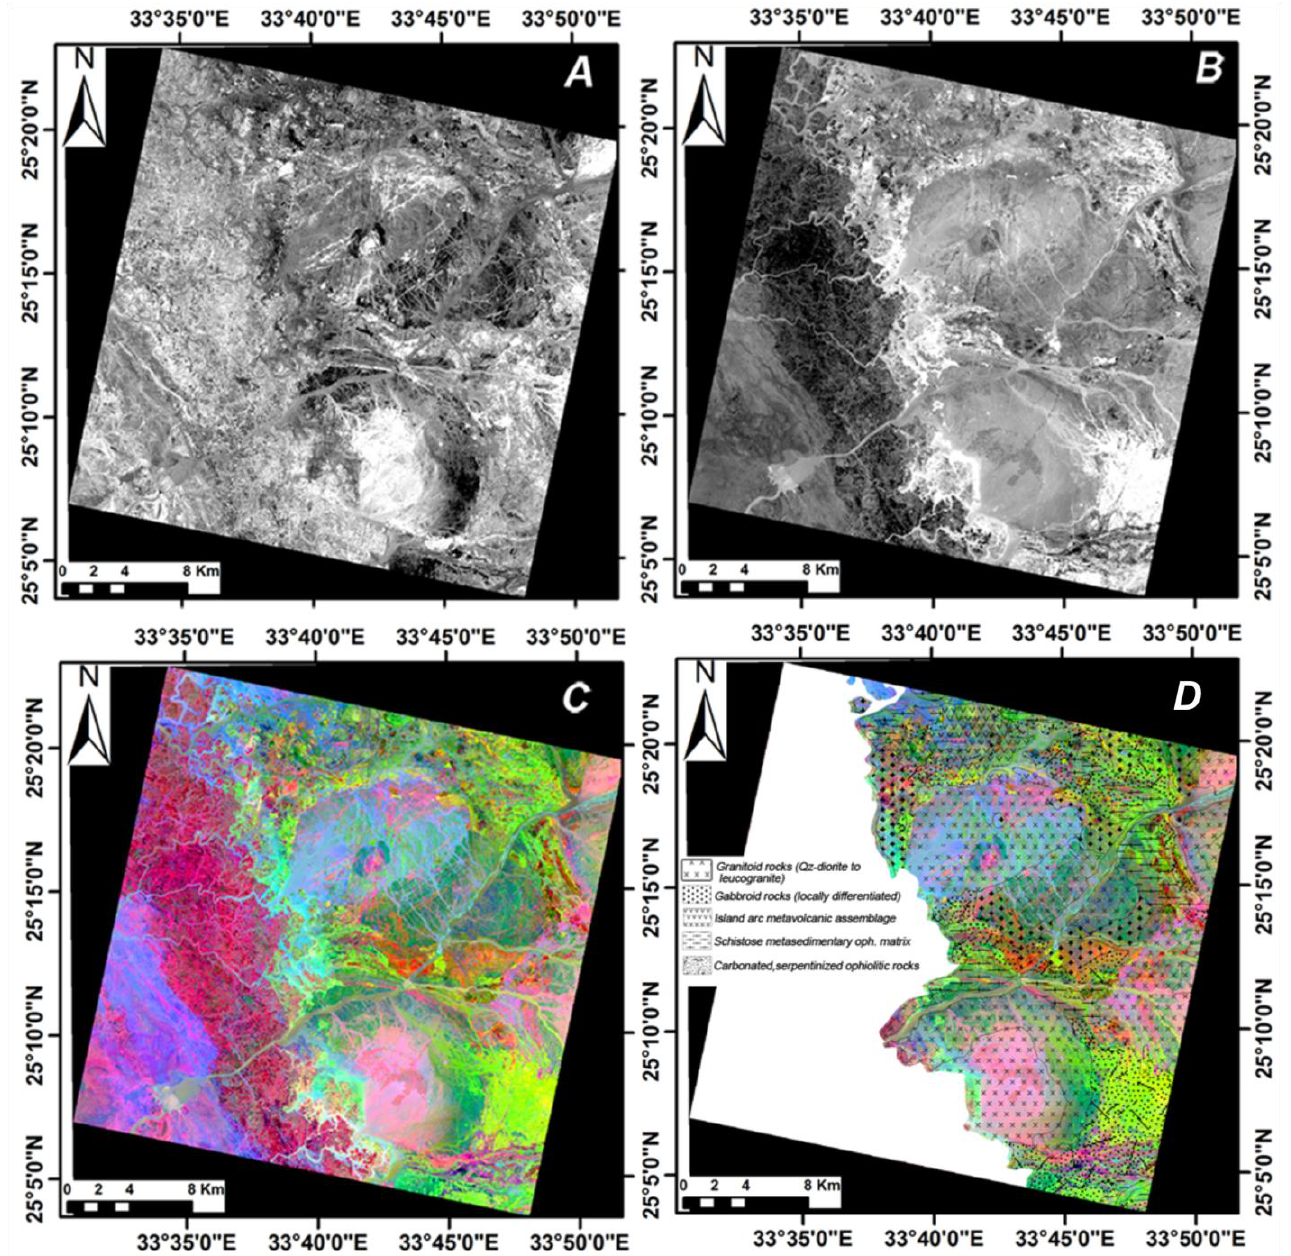
Figure 13. ( A , B ) Greyscale band ratio images of Prisma bands (swir 72/swir 129) and (vnir 50/swir 72). ( C ) FCC band ratio image of Prisma (R: swir 72/swir 129, G: vnir 50/swir 72, and B: vnir 34/vnir 12) and ( D ) lithological mapping based on the spectral results derived from (C).